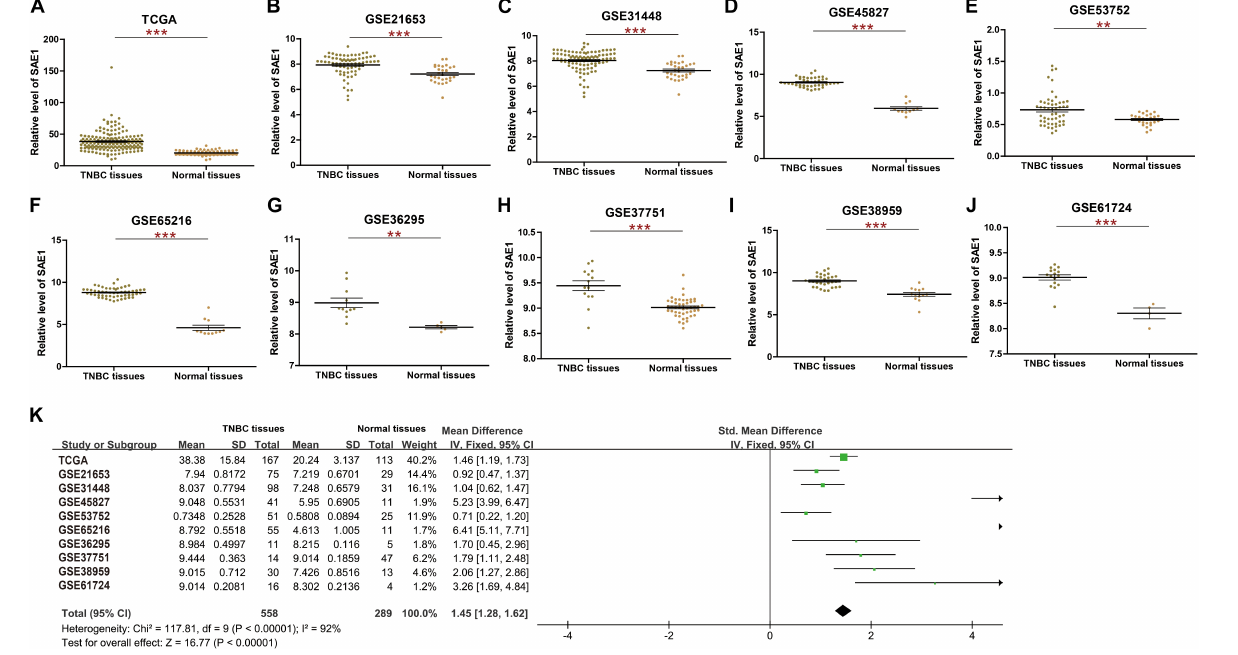
Frontiers in Cell and Developmental Biology |